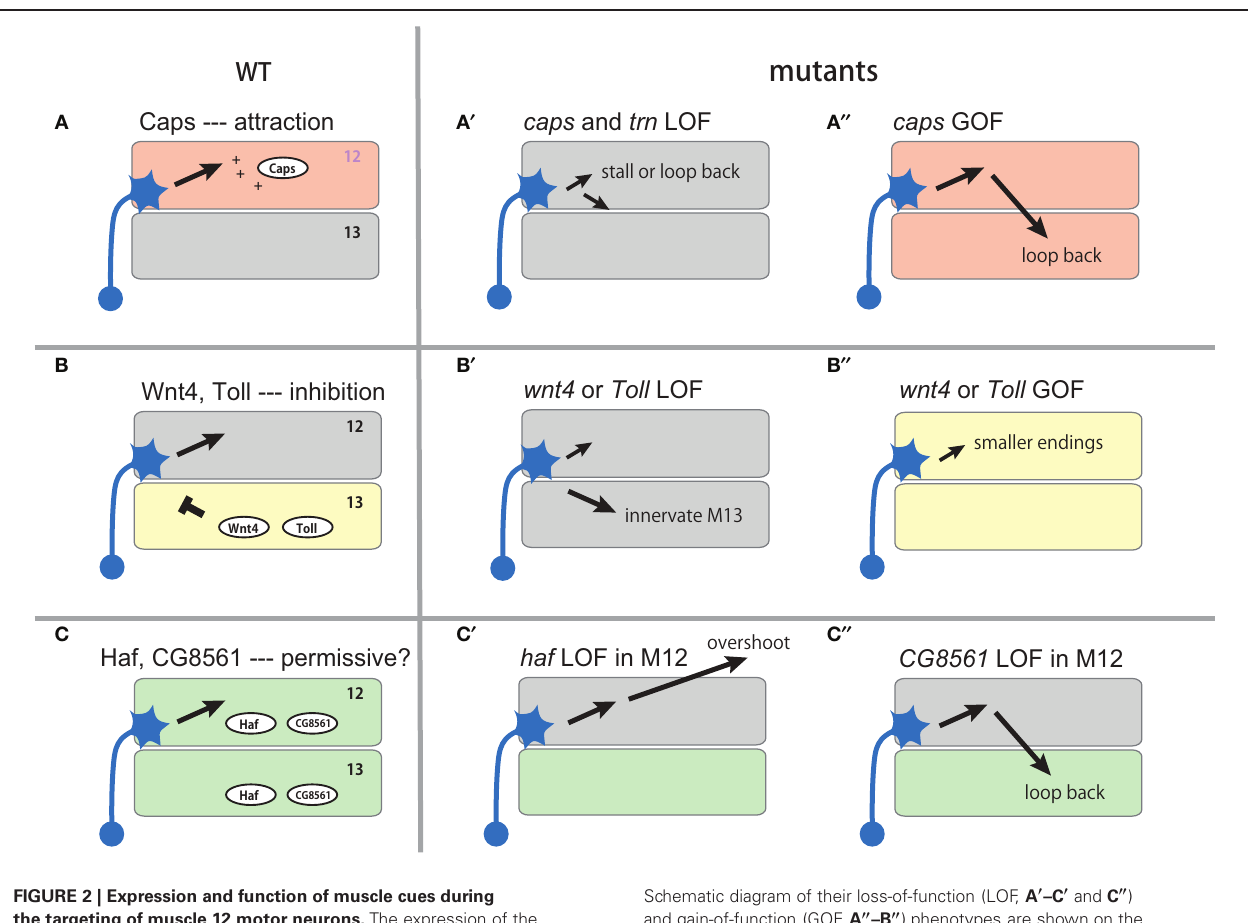
FIGURE 2 | Expression and function of muscle cues during the targeting of muscle 12 motor neurons. The expression of the muscle cues and their putative roles are shown in the left panel (A–C)